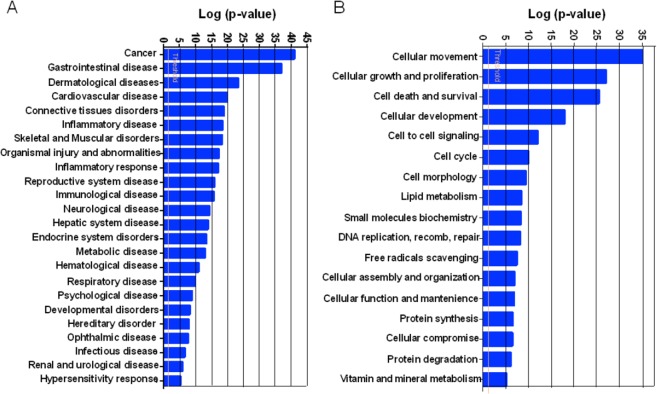
Functional analysis of differentially expressed HGF-CEMP1 genes.Ingenuity pathway analysis showed Diseases and Bio-Functions significantly modulated by CEMP1 expression in HGF/CEMP1 cells (p < 0.05). A total of 1,390 genes were differentially expressed: 260 were up-regulated and 779 were down-regulated. The most significant diseases (A) and bio-functions (B) are shown. Genes that met the p-values <0.05 threshold were associated with biological functions or diseases in the Ingenuity Pathway knowledge. Fischer's exact test was used to calculate the p-value to determine the probability that each biological function/disease assigned to the data set is not due to chance alone.